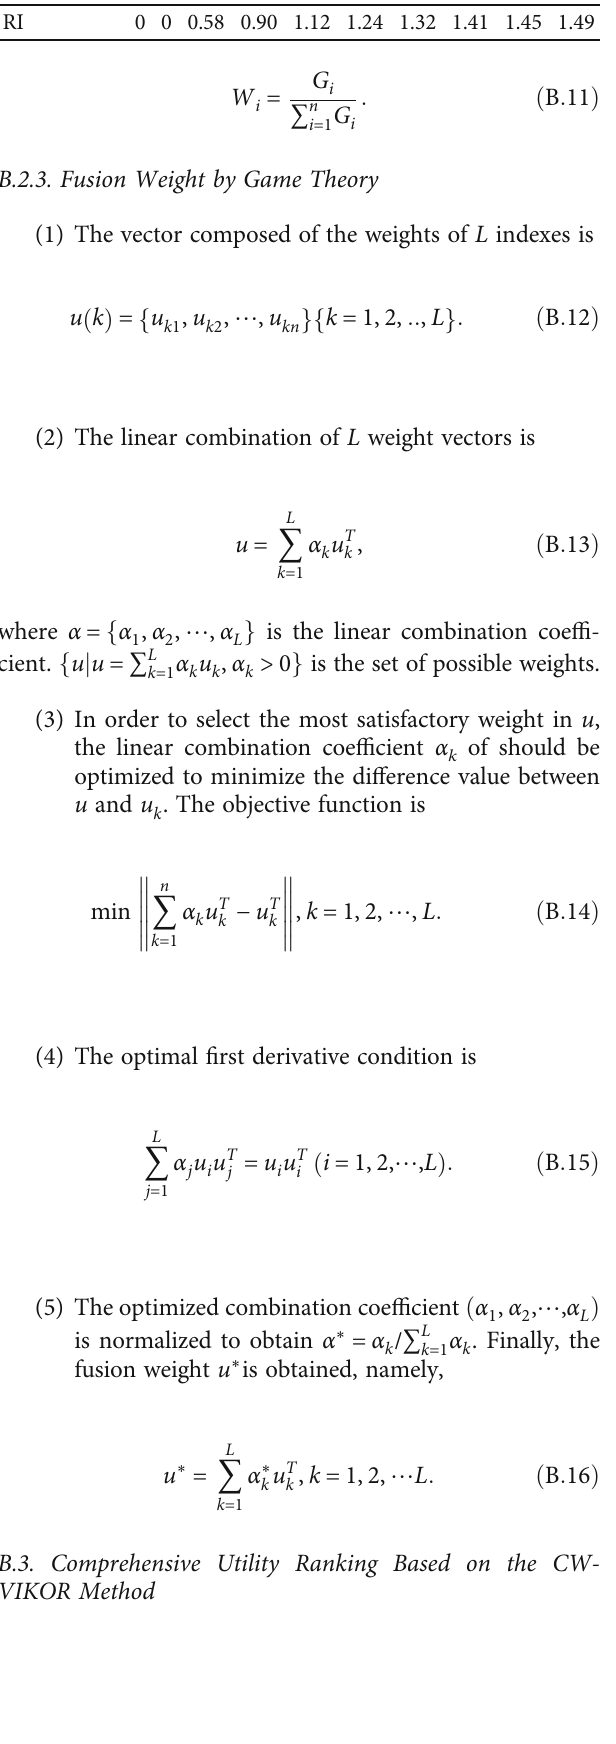
Table 29: Judge the scale and meaning of the matrix. Scale Meaning